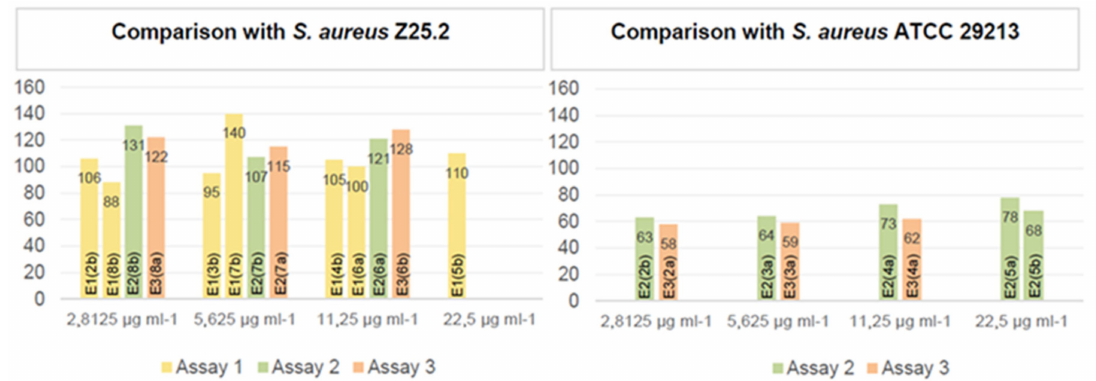
Figure 2. Graphical representation of the number of genes from each sequenced isolate that presented mutations, per assay and per MEGA-plate division from which they were collected, when compared to the original strain from which they derived. On the left, it is possible to compare each isolate with the original S. aureus Z25.2 and, on the right, with the original S. aureus ATCC 29213. E1—assay 1; E2—assay 2; E3—assay 3.